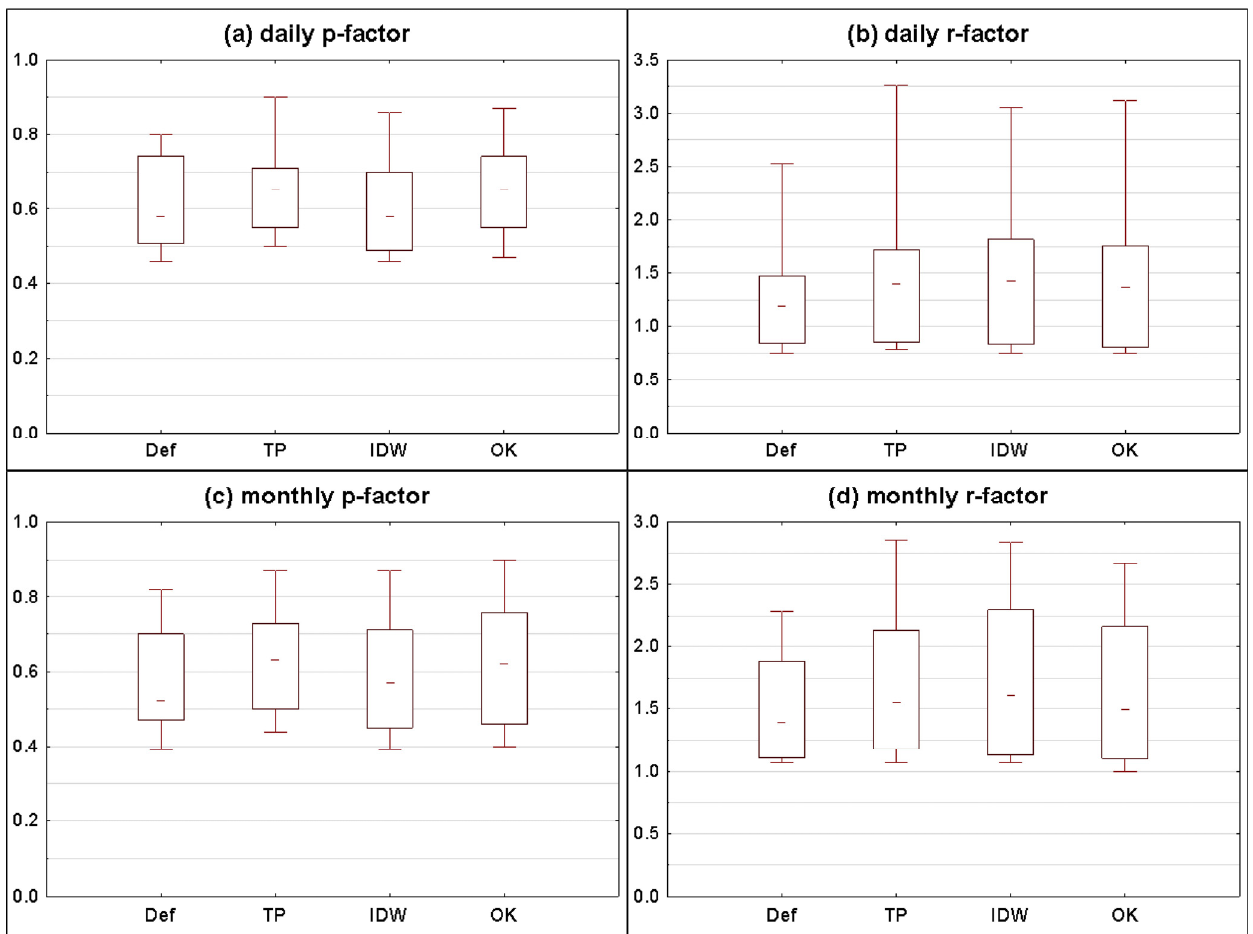
Figure 9. Box plots of uncertainty coefficients across all 11 flow gauging stations for different interpolation methods (Def—Default version, TP—Thiessen Polygons,